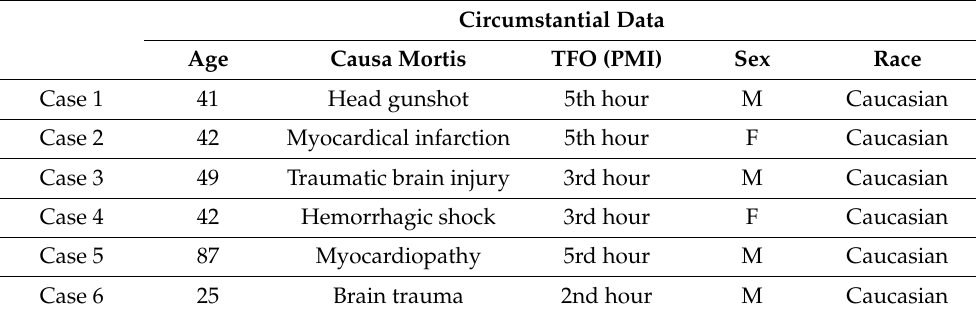
Table 1. Epidemiological data. TFO = Time of first observation PMI = Postmortem